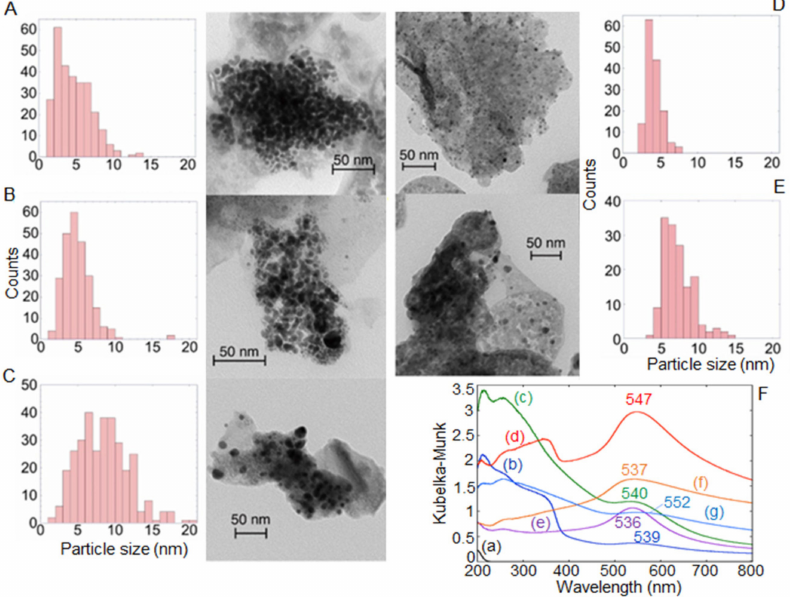
Figure 5. TEM images and analysis for ( A ) Au/Zn2Al-Rec-1, ( B ) Au/Zn2Al-Rec-2, ( C ) Au/Zn2Al- Rec-3-Light, ( D ) Au/Zn2Al-Imp-NaBH4, ( E ) Au/Zn2Al-Imp-Lysine and ( F ) UV–vis absorption profiles of (a) Zn2Al-LDH, (b) Au/Zn2Al-Rec-1, (c) Au/Zn2Al- Rec-2, (d) Au/Zn2Al-Rec-3-Light, (e) Au/Zn2Al-Imp-NaBH4, (f) Au/Zn2Al-Imp-Lysine, and (g) Au/Zn2Al-Light(Reprinted from [43] with permission of Elsevier,